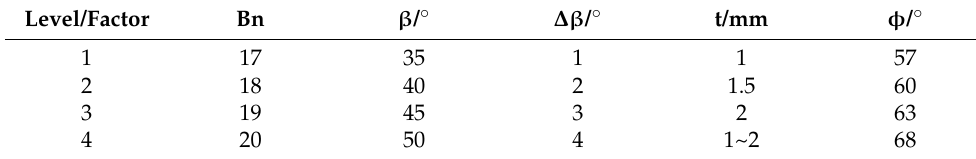
Table 4. Orthogonal test factors and levels.